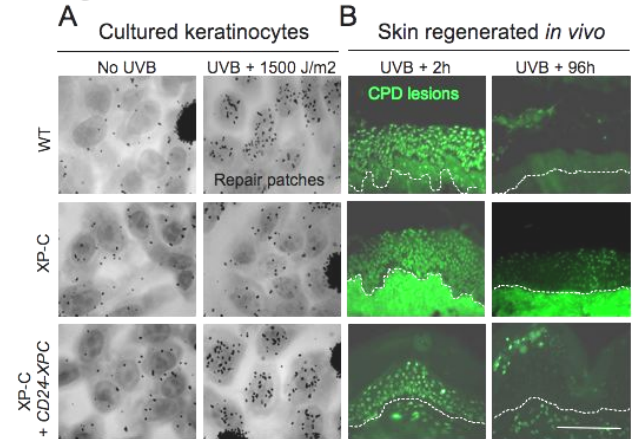
not alter their fate in vivo . Bar, 150 μ